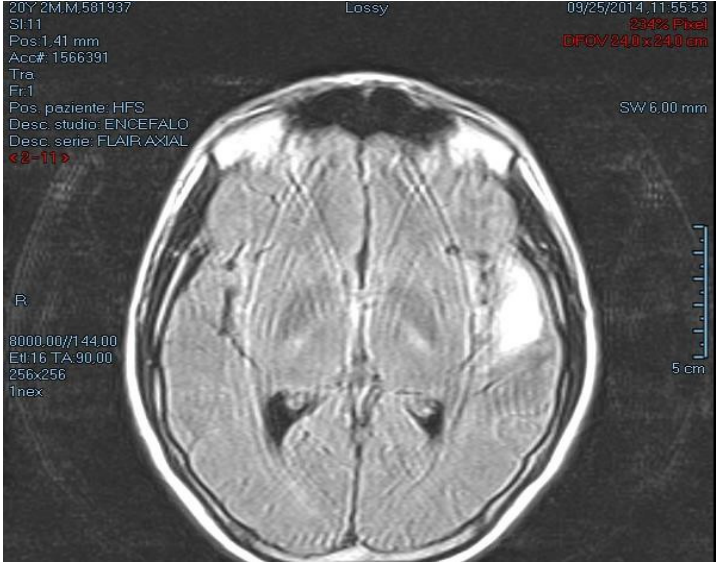
Figure 1. Pre-mortem CT scan of the brain. The right parietal lobe showed inflammatory processes with a hyperdense nodule.